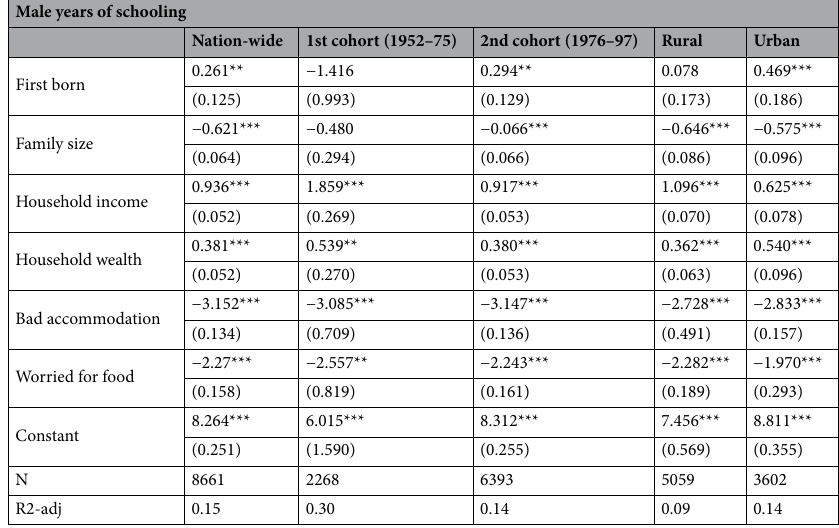
Table 3. The effect of male(son) birth order on own education attainment. Robust standard errors are shown in parenthesis *p < 0.10, **p < 0.05, *** <